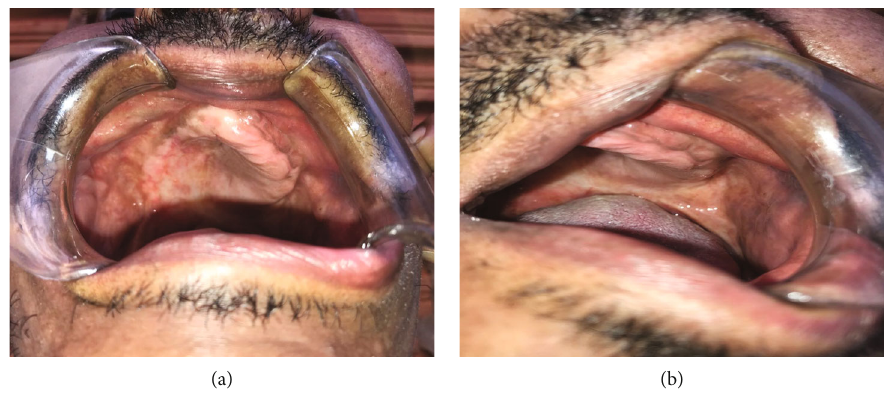
Figure 3: After twelve months, the clinical regression of oral histoplasmosis